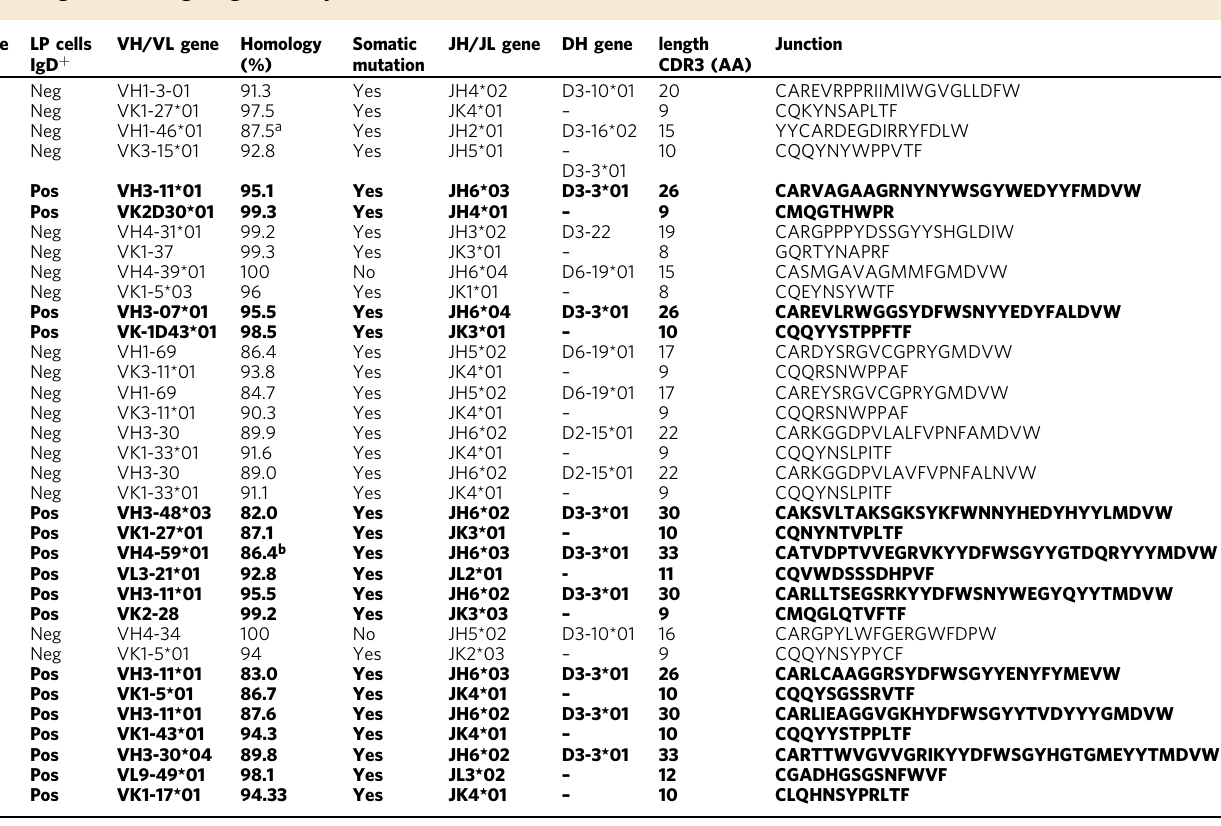
Table 2 Ig variable region gene analysis of LP